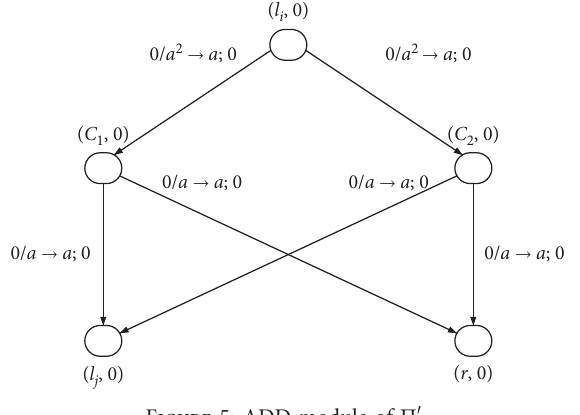
Figure 5: ADD module of Π ′ .